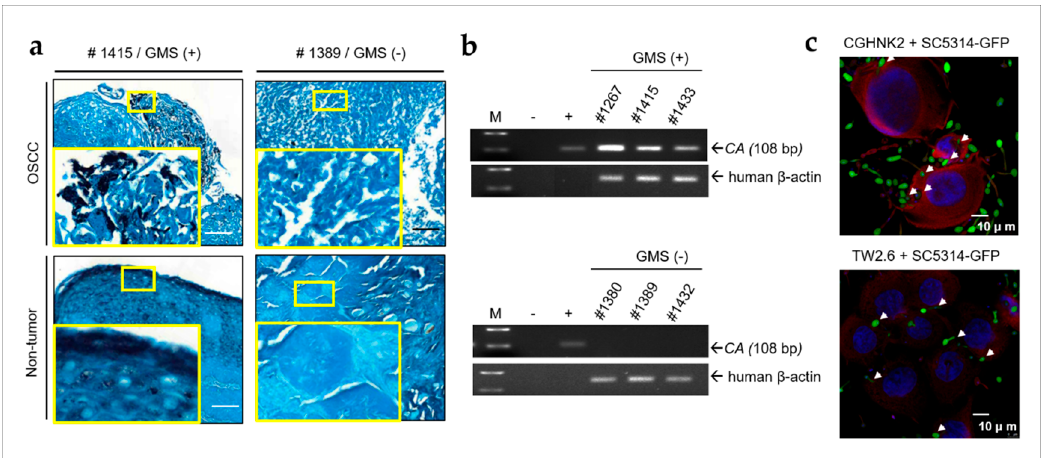
Figure 1. CA ( Candida albicans ) is present in oral specimens from patients with OSCC (oral squamous cell carcinoma) and invaded CGHNK2 and TW2.6 cell lines. ( a ) GMS (Gomori methenamine silver) stain showing the presence of fungi in OSCC tumor and adjacent non-tumor tissues. Fungus was black stained. The number in each picture indicates the sample code. GMS-negative samples were shown as controls. Small and large yellow frames indicate the original and magnified areas, respectively. Bar, 100 μ m. ( b ) Gel views of PCR products obtained with DNA extracted from OSCC biopsies. M, molecular weight marker (100-bp ladder); − , negative control; +, PCR carried out with DNA isolated from CA SC5314 as positive control. The size of the CA PCR product is indicated by an arrow (108 bp). Human β -actin PCR product used as internal control for each OSCC samples. ( c ) CA invade cultured human untransformed CGHNK2 and OSCC TW2.6 cell lines. Immunofluorescence confocal micrograph of CGHNK2 and TW2.6 cells after coculture with CA strain SC5314 expressing GFP (SC5314-GFP, MOI of 100) for 1 h. Invading intracellular CA (green) were confirmed by the single optical section through the host cells and indicated by white arrows. Fixed CGHNK2 and TW2.6 cells were stained with phalloidin-TRITC (red) to show filamentous actin. The nuclear counter stain is DAPI (4 ′ ,6-diamidino-2-phenylindole, blue). Bar, 10 μ m.